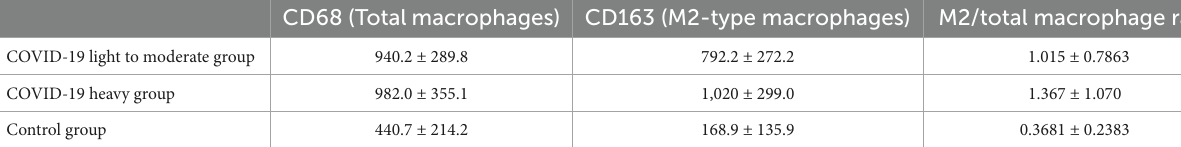
TABLE 4 Results of macrophage counting in COVID-19 group, paraquat group and Control group.